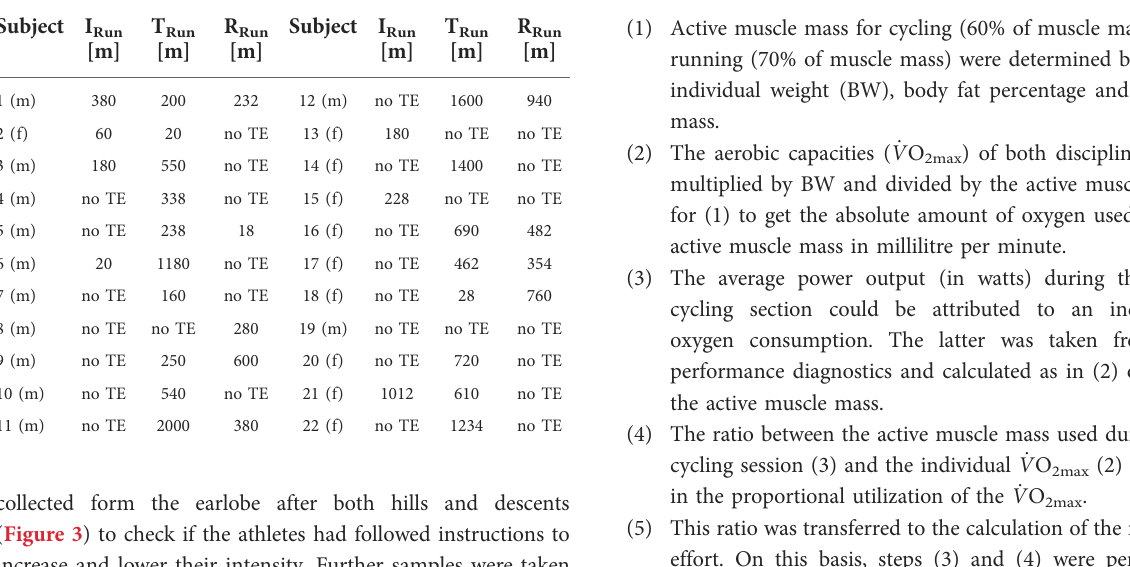
TABLE 2 Distance over which transient effects (TE) were observed in meters. The cases who showed no transient effect are labelled as “ no TE ” . f=female; m=Male subject.